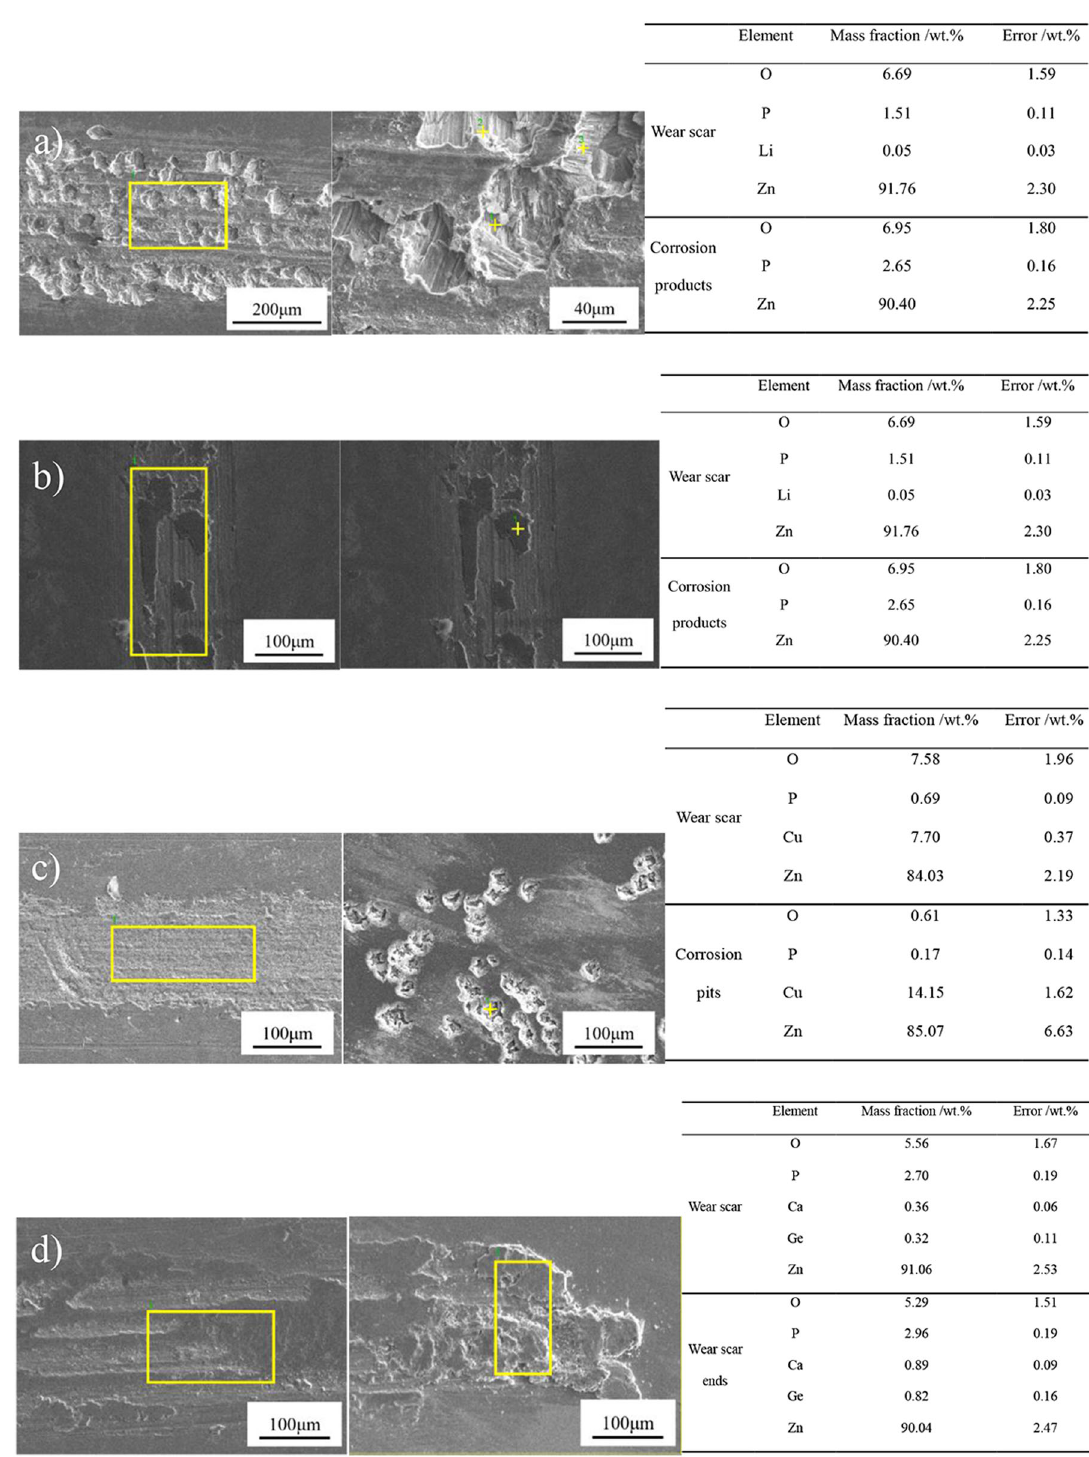
Fig. 5 Elemental distributions of wear scars and debris of samples tested under Hank ’ s solution condition analyzed by EDS: ( a ) pure Zn; ( b ) Zn- 0.5Li; ( c ) Zn-1Cu; and ( d )